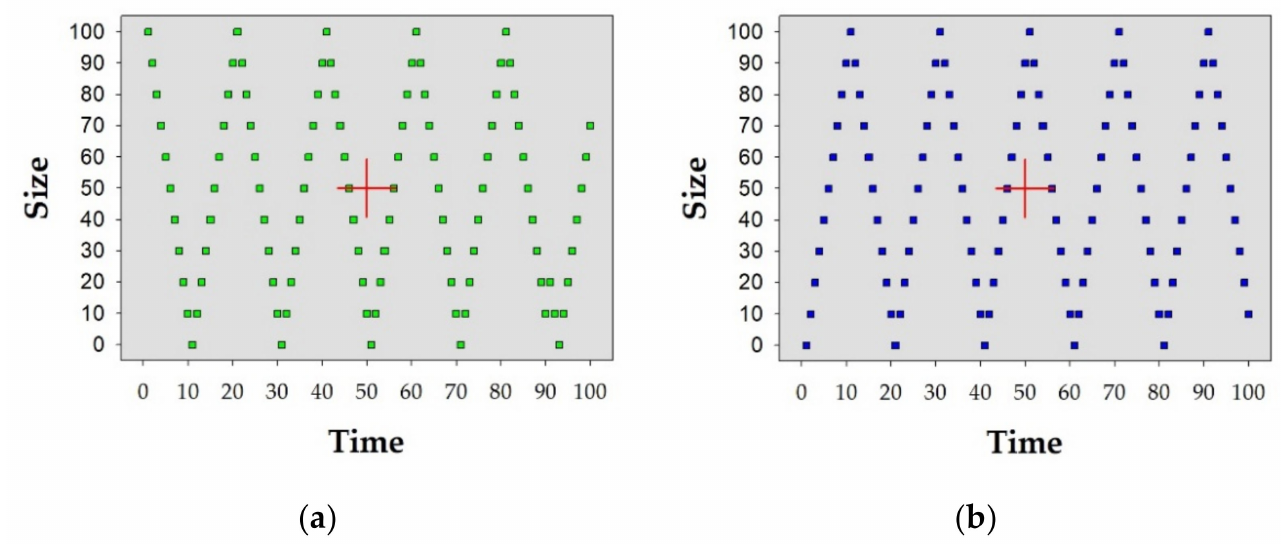
Figure 2. We compared the temporal pattern similarity of two time-series data sets by measuring the similarity of the PDFs of distance ( δ ) and angle ( θ ) from the centroid of the graphs where all time-series data sets under comparison were plotted (red cross) to each point within the pair of time series data sets ( a , b ).